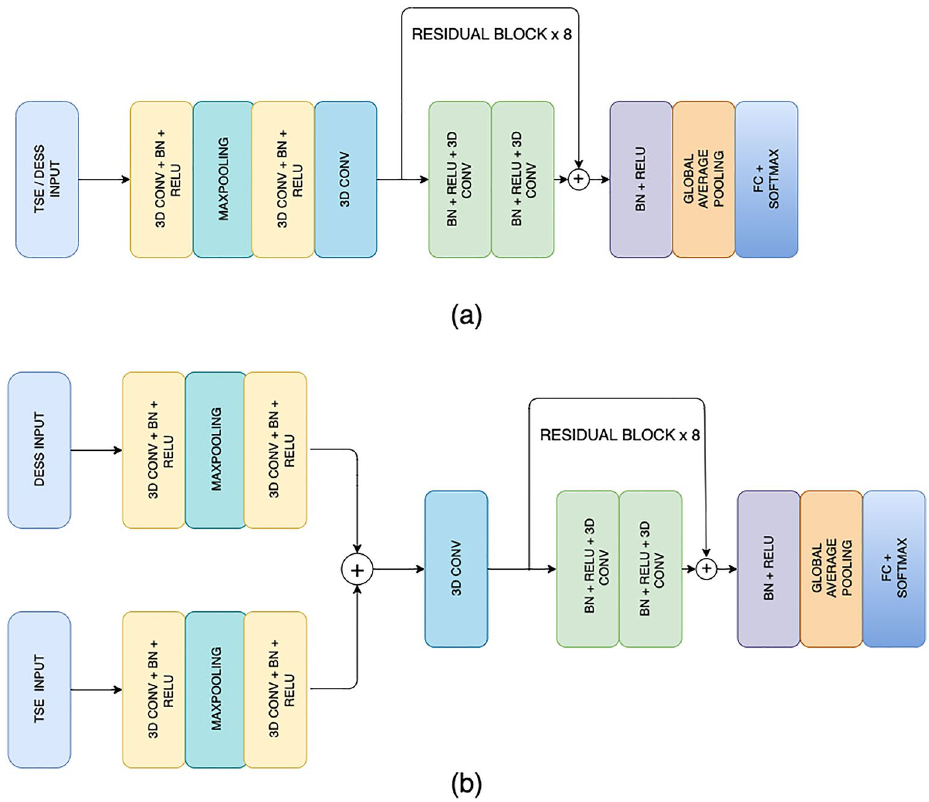
Figure 2. ( a ) Architecture of the coronal intermediate-weighted turbo spin-echo (IW-TSE), sagittal fat- suppressed intermediate-weighted turbo spin-echo (FS-IW-TSE), and fat-suppressed three-dimensional dual- echo in steady-state (DESS) models. ( b ) Architecture of the multi-input MRI